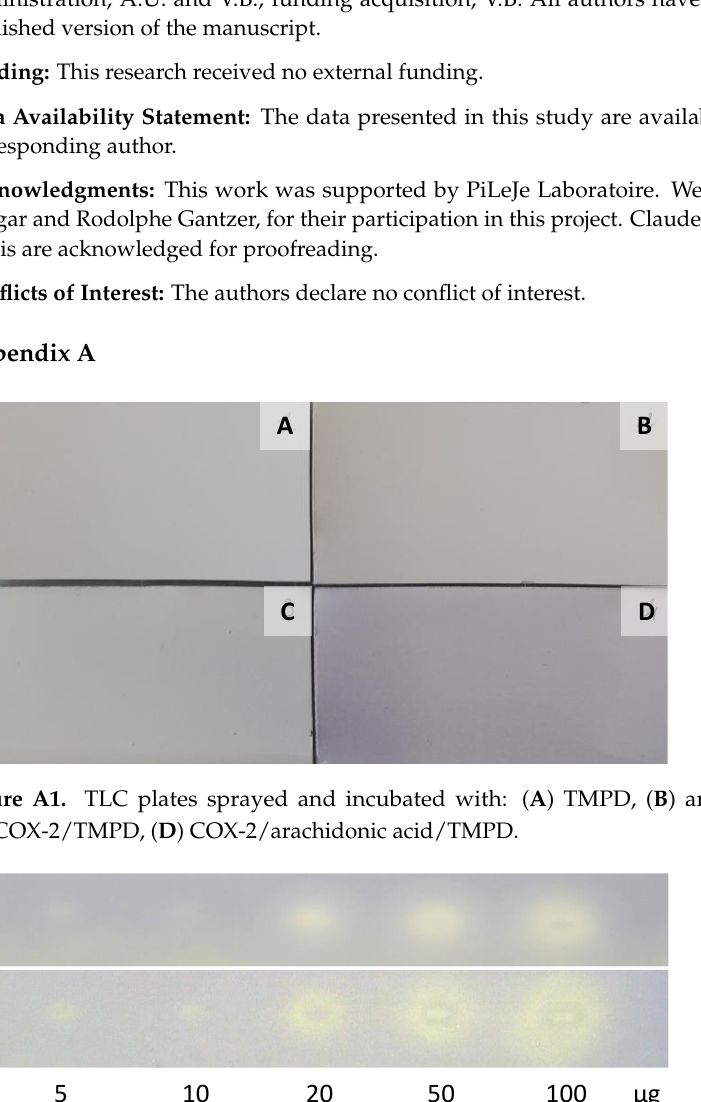
Figure A3. HPTLC plates of Fomitopsis pinicola EtOAc extract (50 µg). Detection ( a ) under UV at 366 nm, ( b ) with vanillin-sulfuric acid reagent, ( c ) with DPPH, ( d ) with COX-2/arachidonic acid/TMPD.